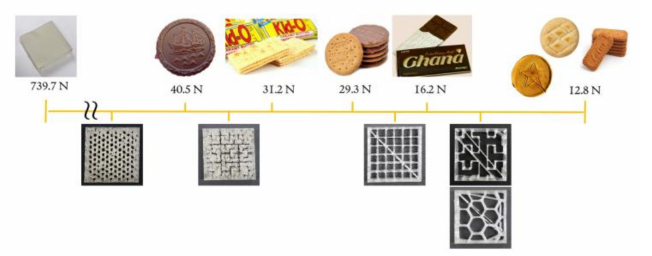
Figure 11. Comparison of flexural force levels needed to break commercial